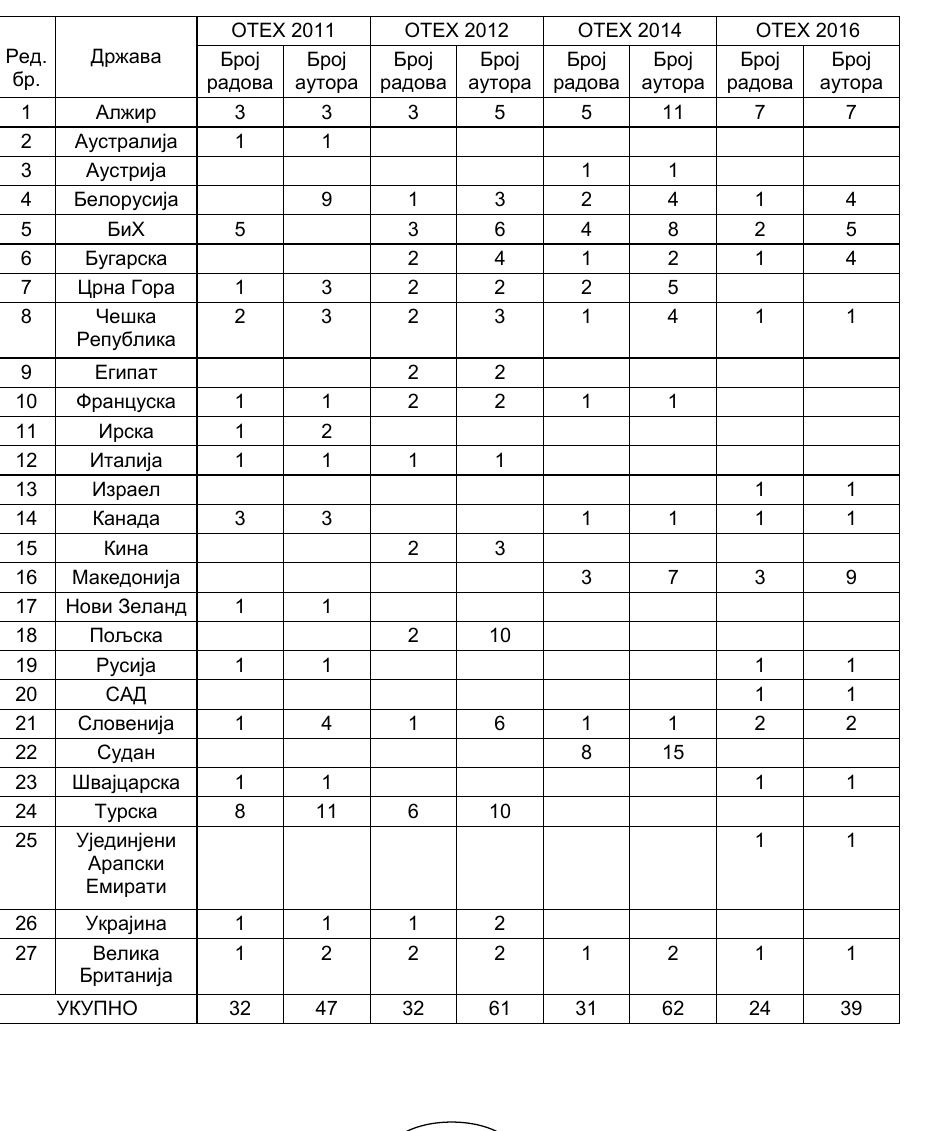
Table 3 – Overview of the number of papers and authors (with coauthors) by the foreign